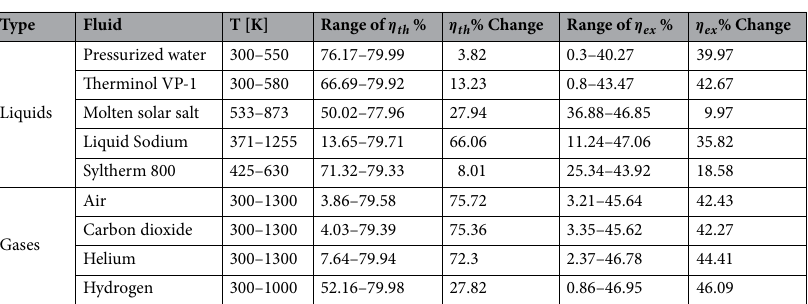
Table 5. Inlet-temperature effect on both thermal and exergetic